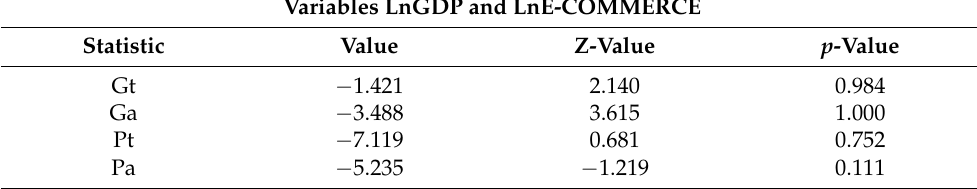
Table 8. Westerlund panel cointegration